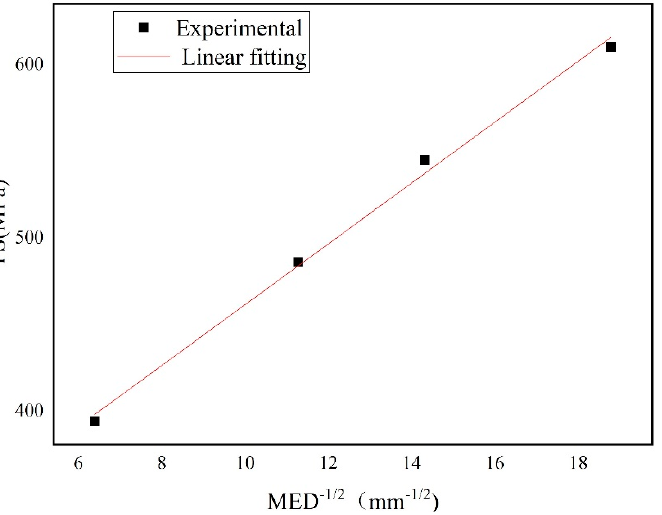
Figure 12. Function relationship between YS of samples at different heat inputs and the MED − 1/2 in the MTA range of 2–15°.